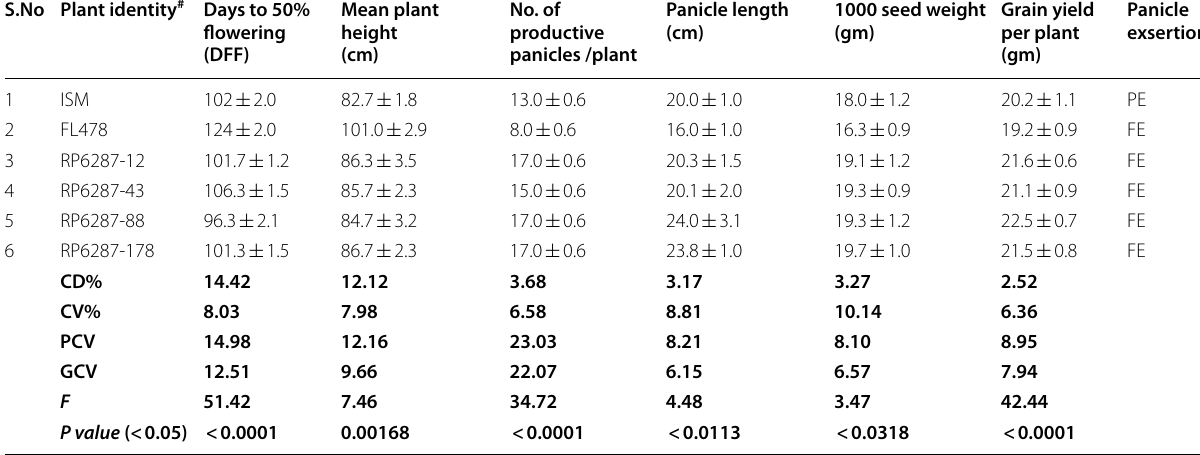
Table 2 Analysis of agro-morphological characters of ISM introgressed lines for salinity tolerance along with parents under field conditions at ICAR-IIRR (Wet season, June to November 2018)